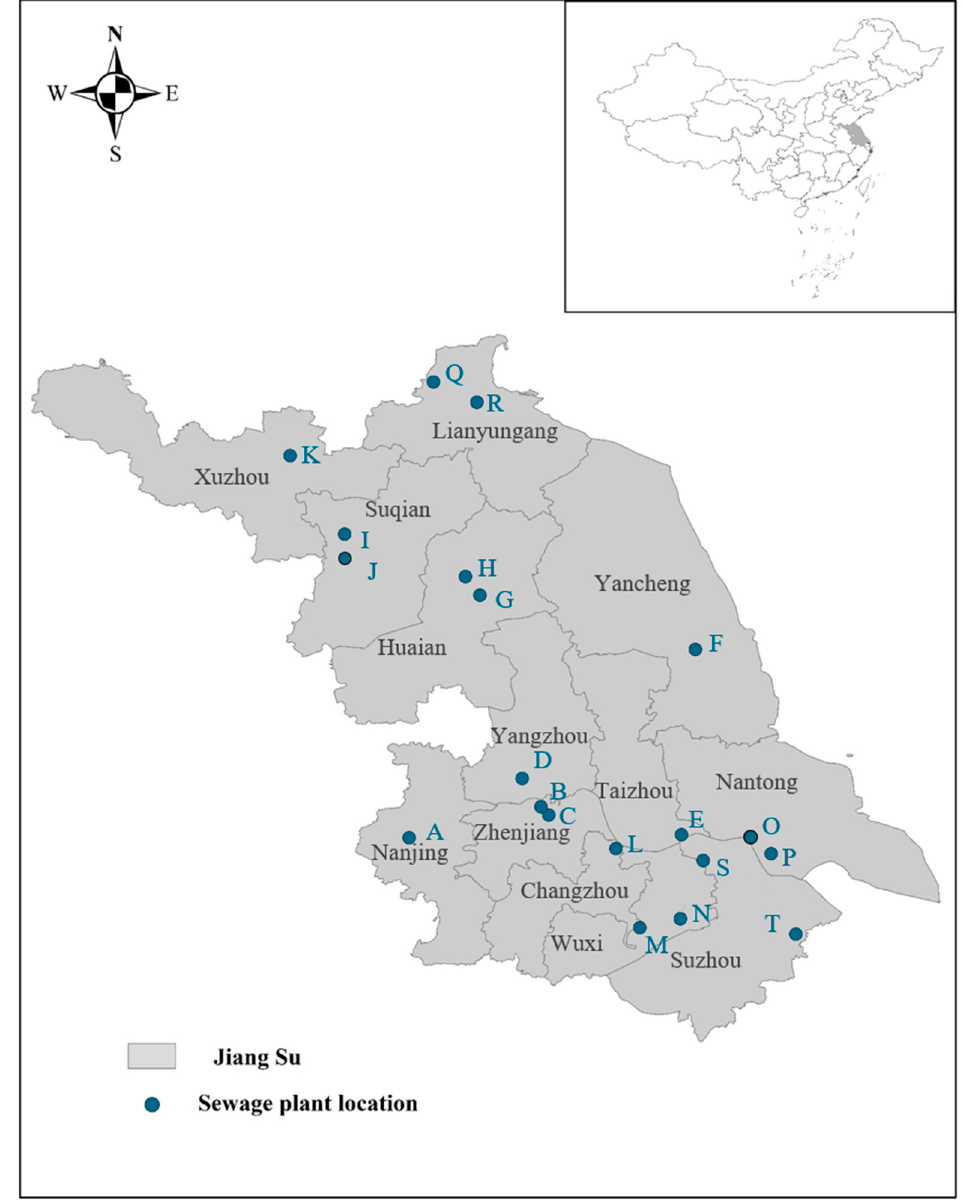
Figure 1. The location distribution of 20 sewage plants in Jiangsu Province.